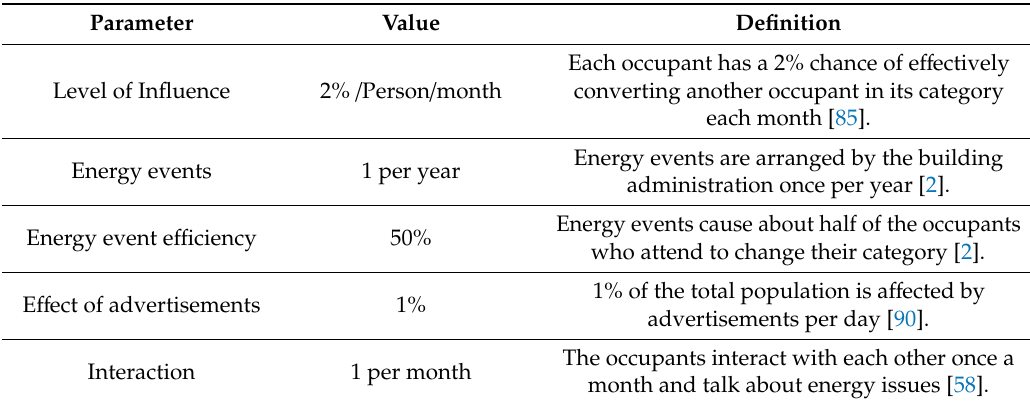
Table 3. Parameters and their values used in the model.